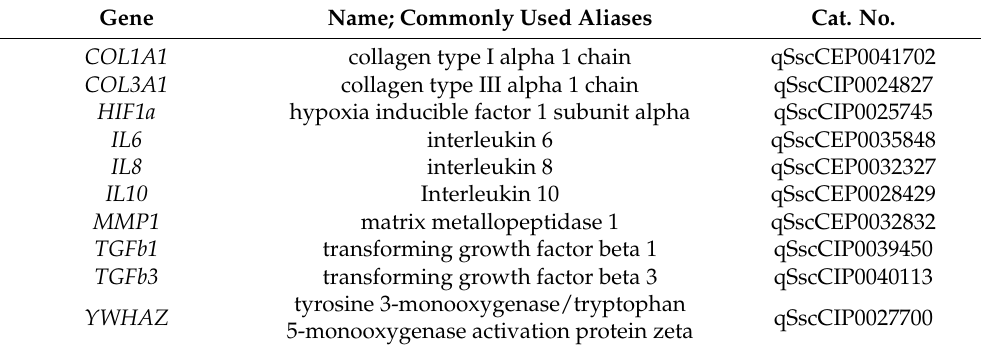
Table 1. PrimePCR™ Probe Assays (Bio-Rad Laboratories, Inc., Hercules, CA, USA). Gene Name; Commonly Used Aliases Cat.